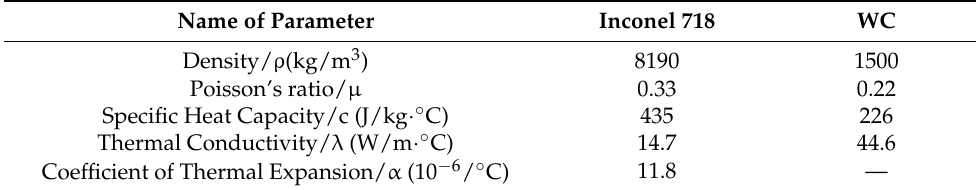
Table 1. The characteristic parameters of two materials [30,31].